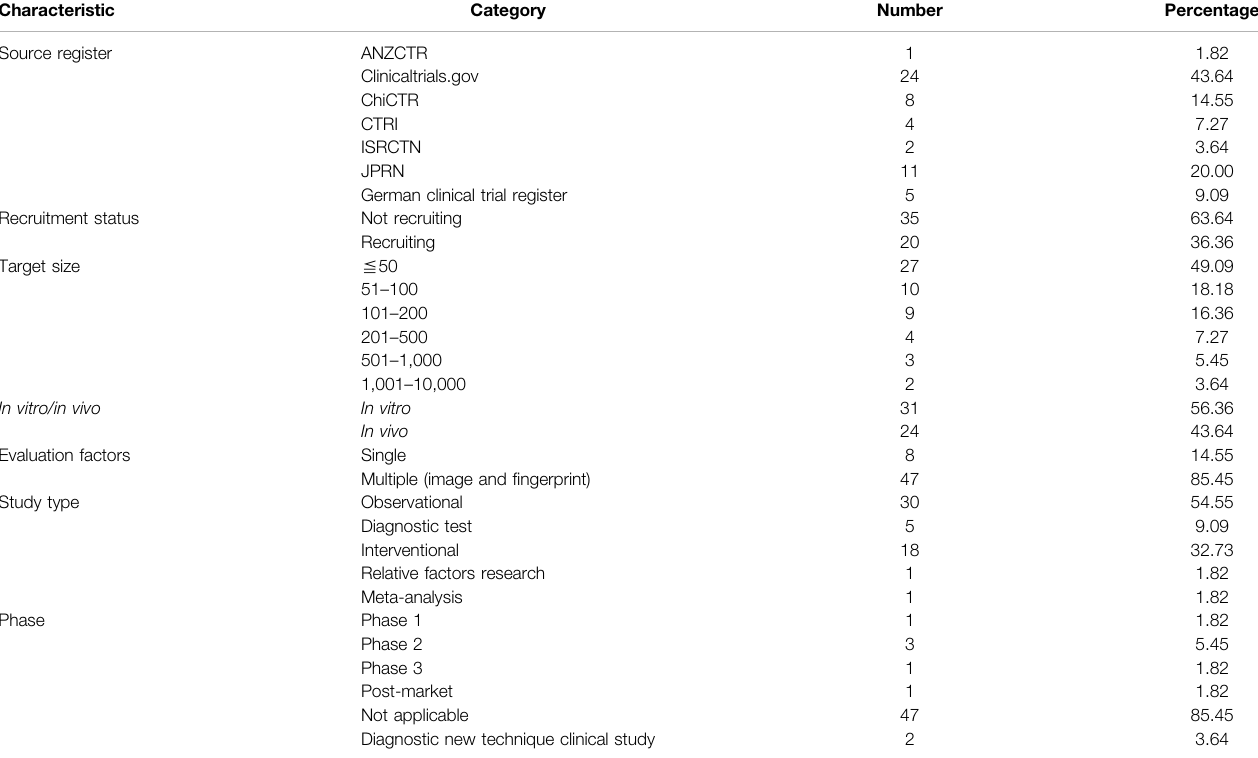
TABLE 1 | Characteristics of registered Raman spectroscopy clinical